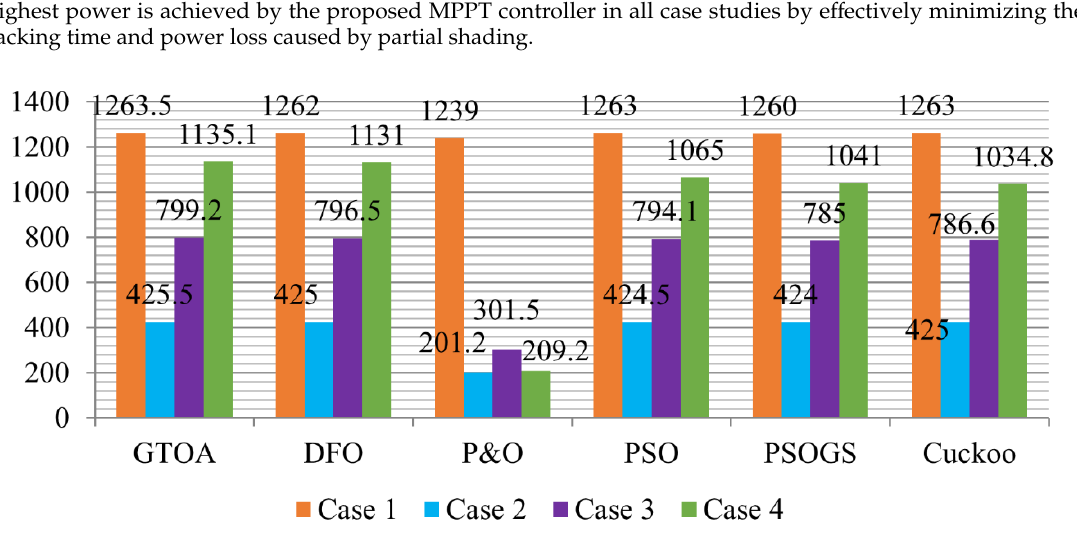
Figure A1. Power tracked by MPPT techniques in all Figure A1 . Power tracked by MPPT techniques in all cases